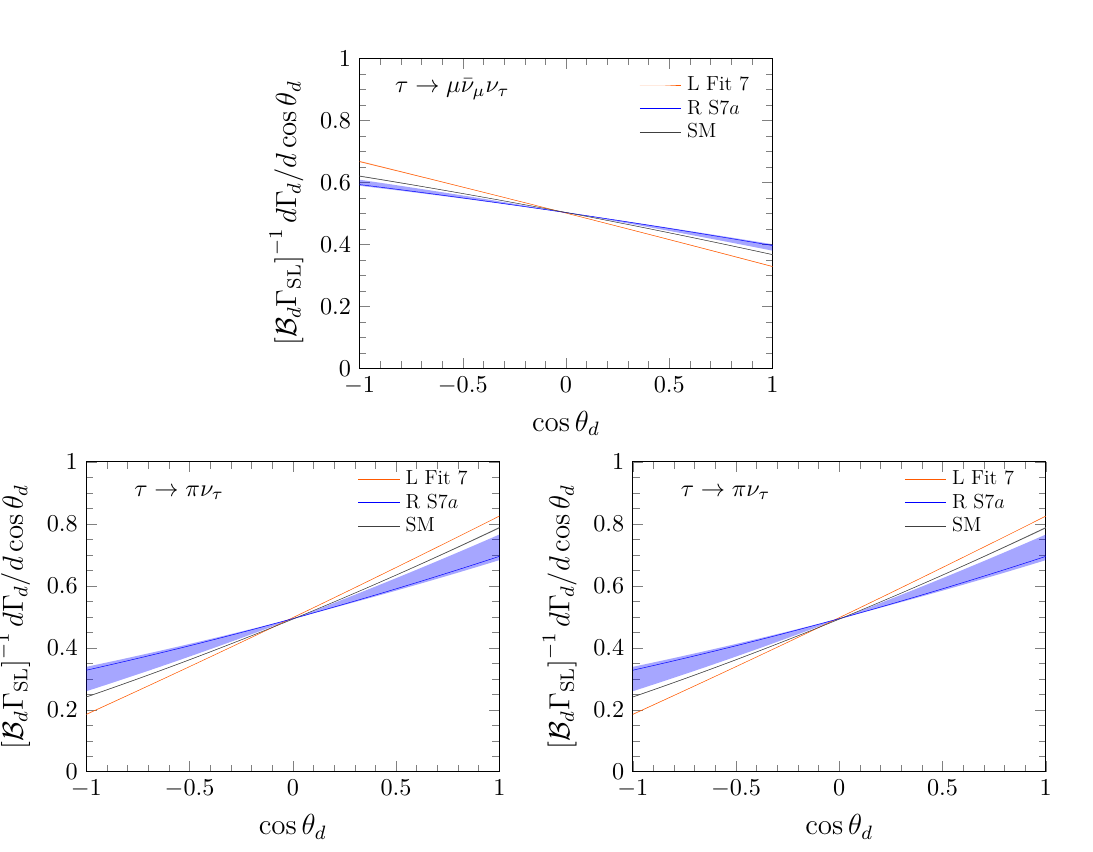
Figure 10 . Same as in figure 9, but for the ¯ B → D ∗ τ ( µ ¯ ν µ ν τ , πν τ , ρν τ )¯ ν τ decays.